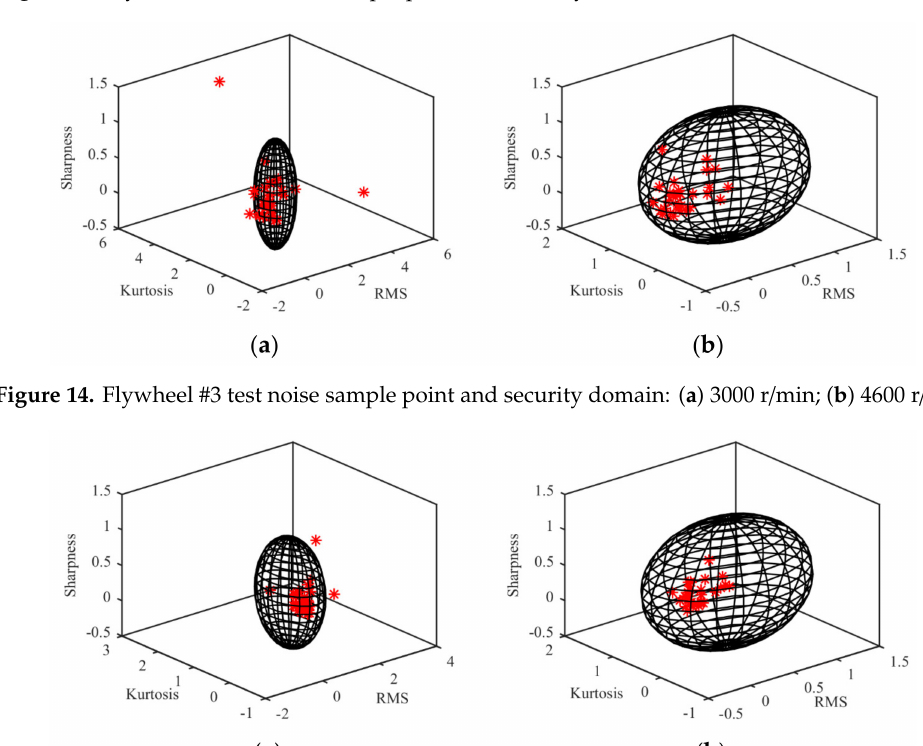
Figure 13. Flywheel #2 test noise sample point and security domain; ( a ) 3000 r / min; ( b )4600 r / min.